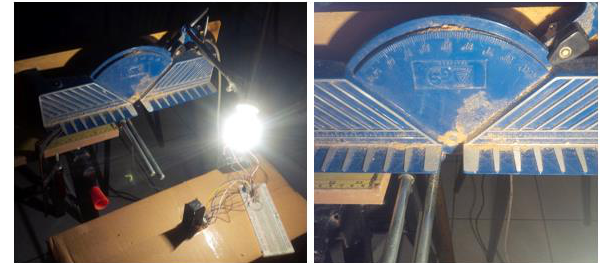
Figure 11. First experimental set up (light radiation).